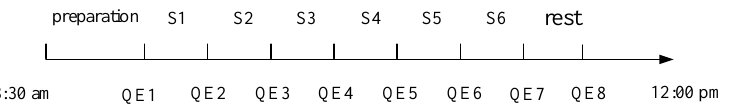
Figure 1. Measurement protocol of the vocal loading task in the vocal fatigue study. QE i ( i = 1,2,..,8 ) : Quality Evaluation; S i ( i = 1,2,..,6 ) represents each vocal loading task